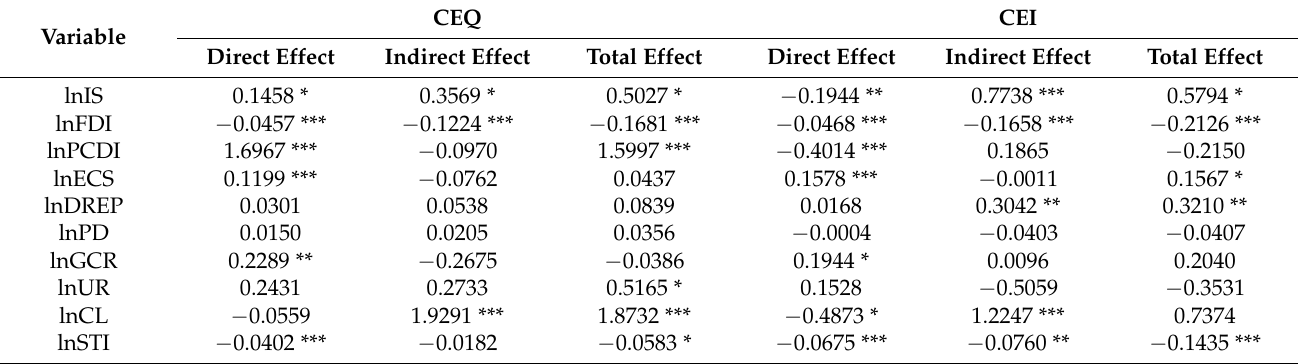
Table 10. Decomposition of carbon emission intensity effect of urban production energy